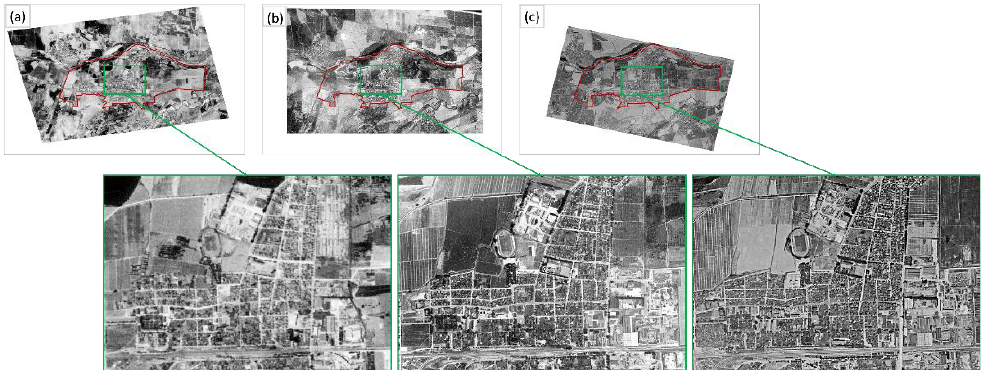
Figure 11. Stamboliyski captured by ( a ) Corona image from 1968, ( b , c ) Hexagon images from 1975 and 1980, respectively (finer details of the region from Stamboliyski town center are shown in the inset images highlighted by green boxes).